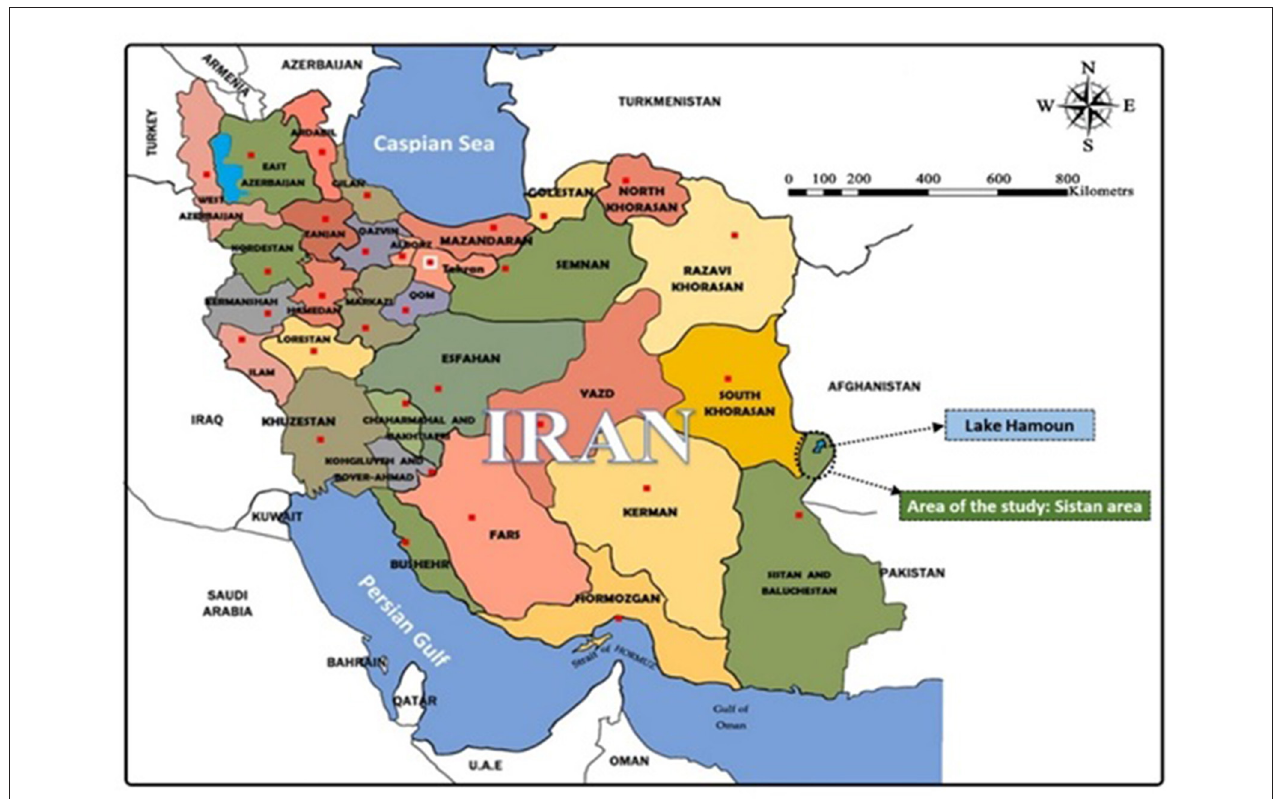
FIGURE 2 | The location map of Sistan area in